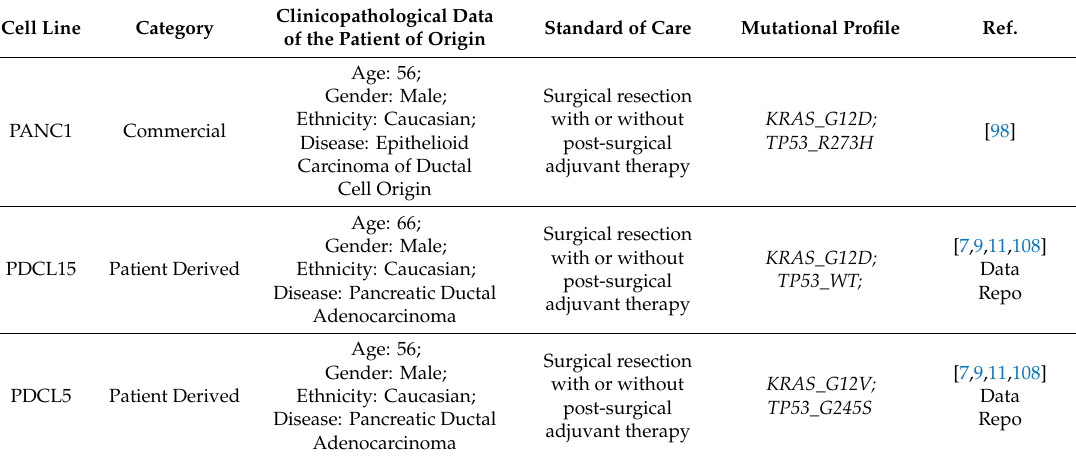
Table A2. Cell line profiles.